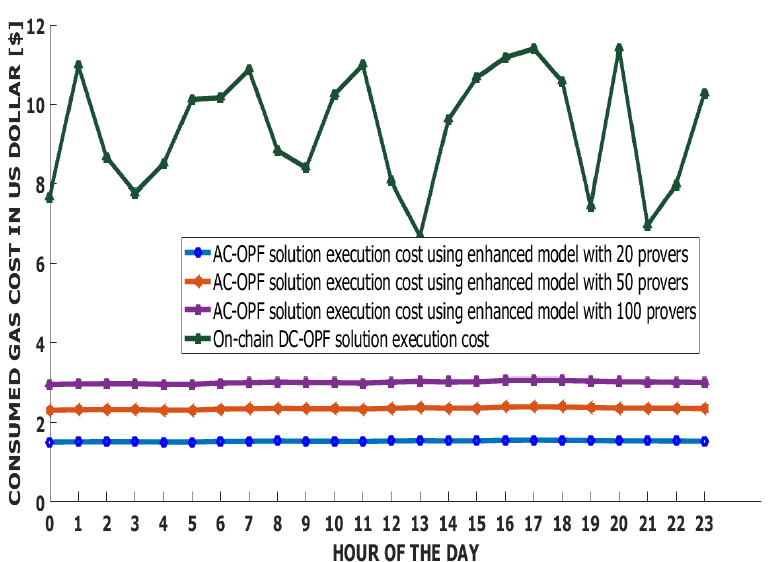
Figure 12. Comparison of execution costs between on-chain OPF solutions for a 3-bus DC-OPF problem and the solution for a 14-bus AC-OPF problem using the enhanced proposed